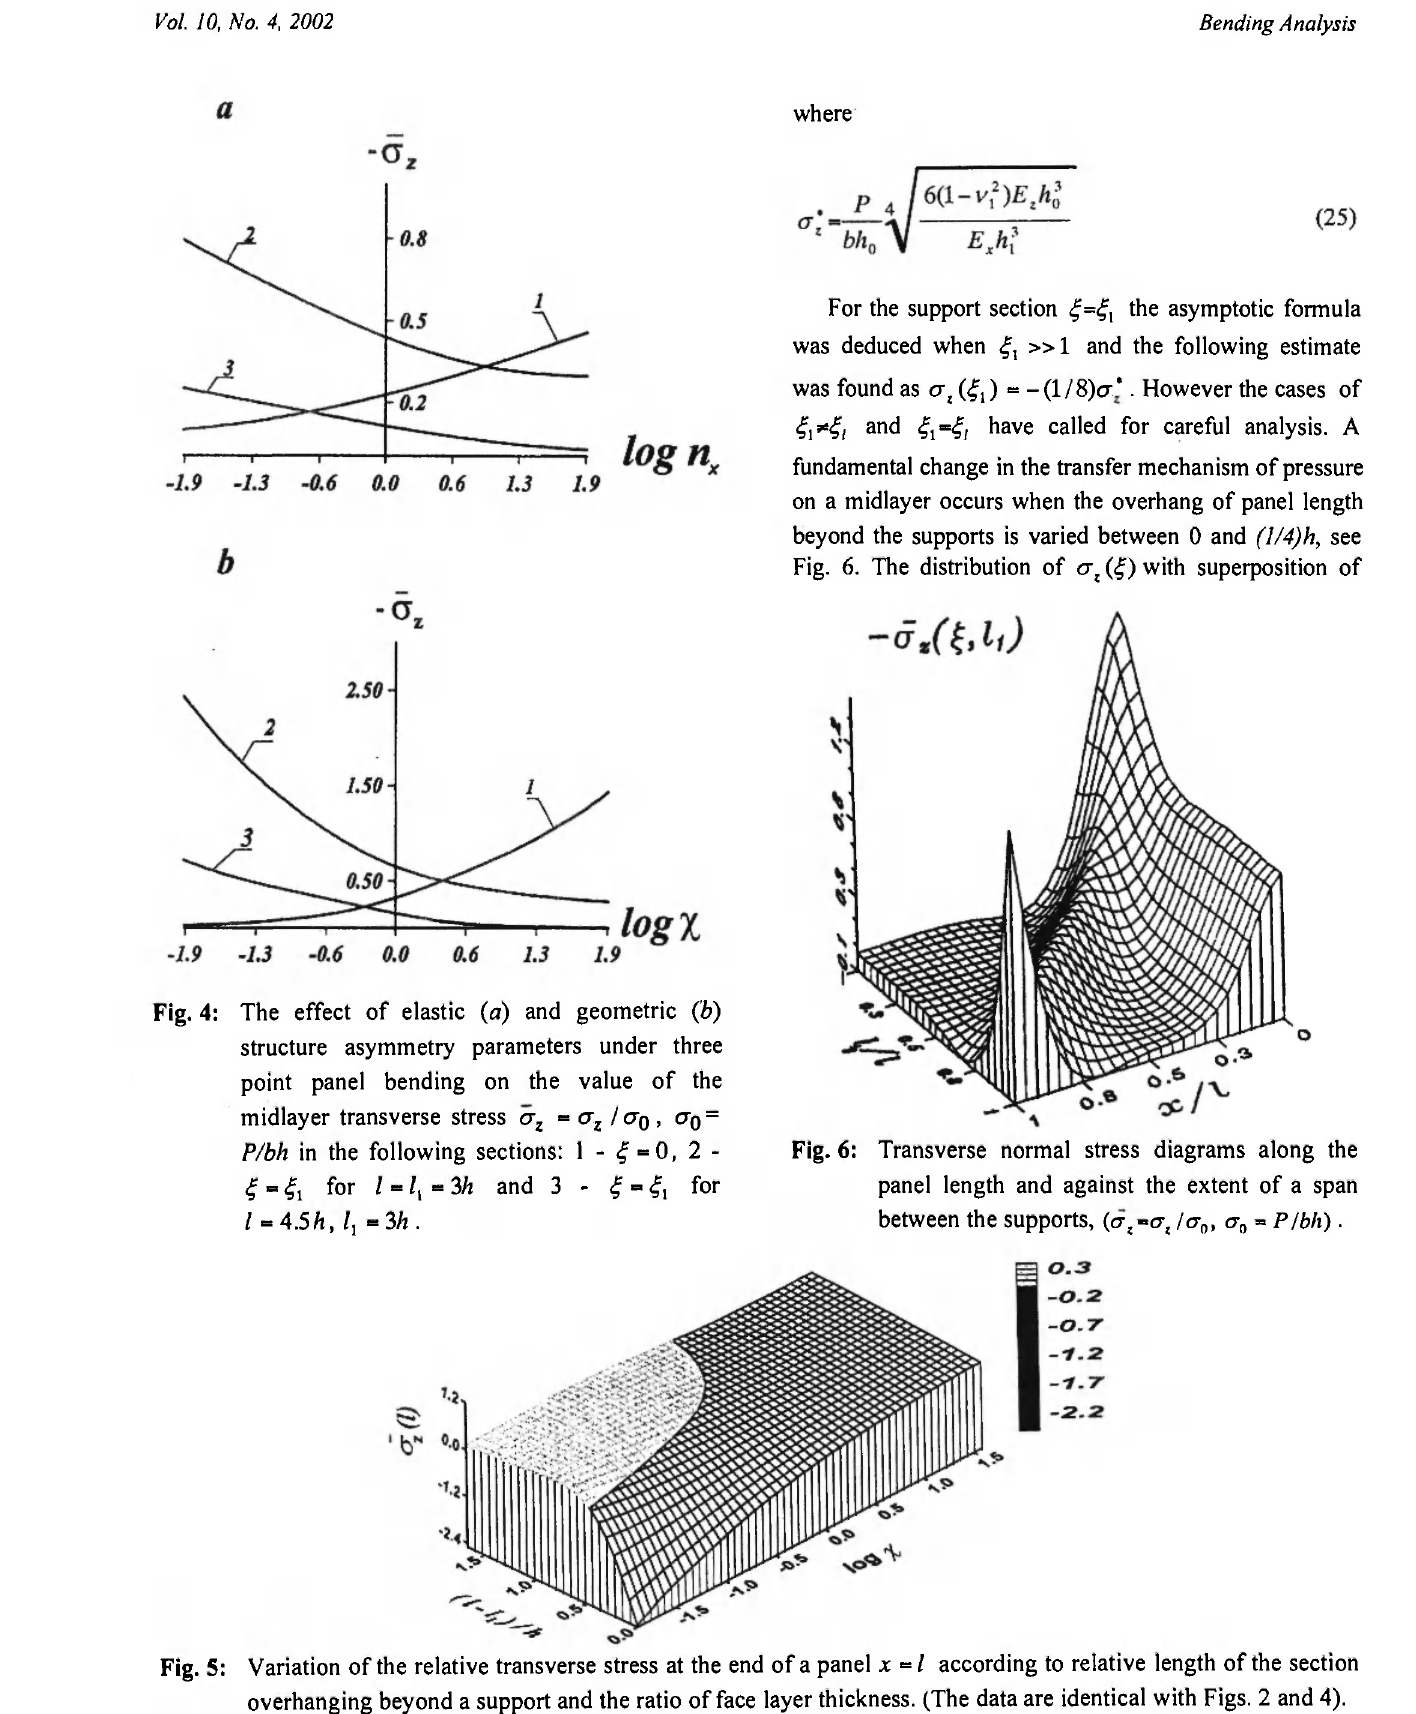
Fig. 5: Variation of the relative transverse stress at the end of a panel χ = / according to relative length of the section overhanging beyond a support and the ratio of face layer thickness. (The data are identical with Figs. 2 and 4).